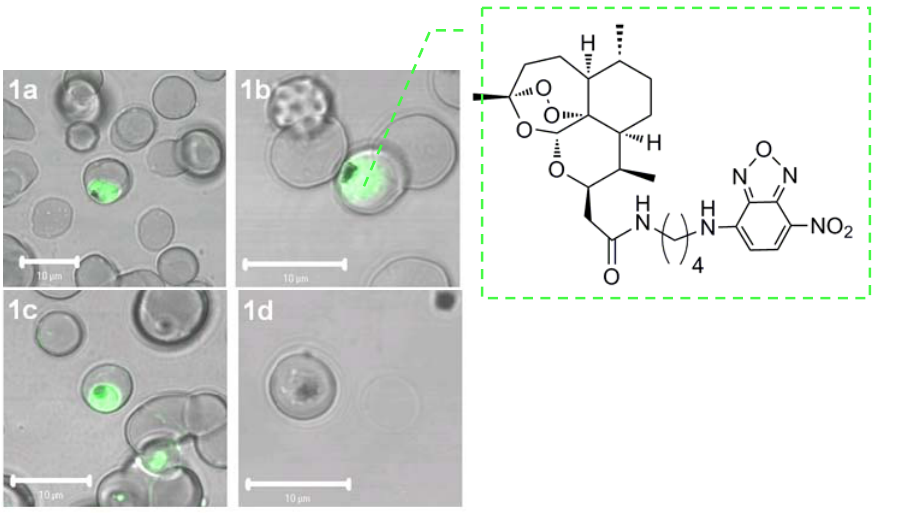
Figure 4. Confocal microscope images of parasite-infected red blood cells incubated with fluorescent artemisinin nitrobenzodiazole (NBD) conjugate without iron chelator DFO before (1a) and after wash (1b), and with DFO (100 µM) before (1c) and after wash (1d)